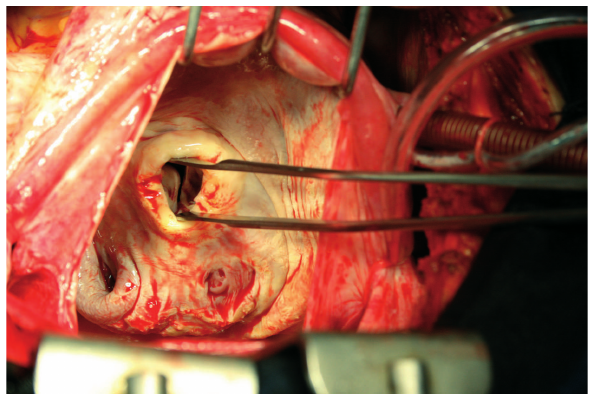
esquerdoFig. Fig. 3 - Ressecção triangular tangencial do átrio